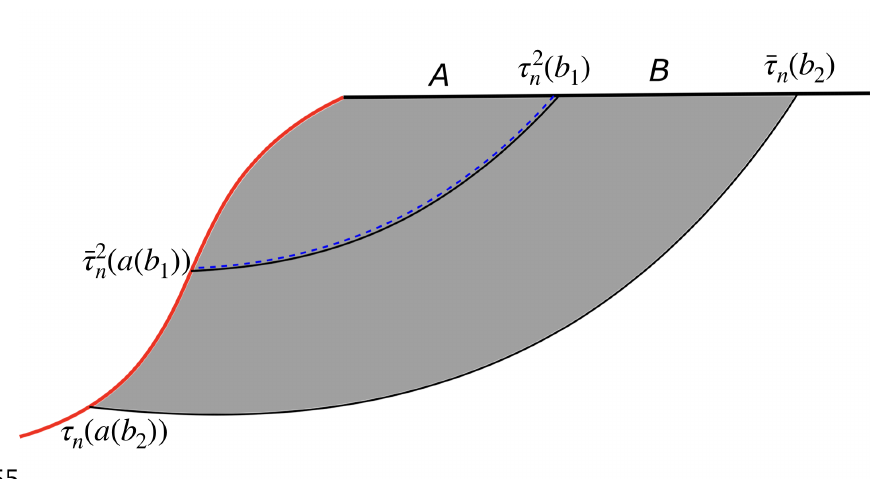
Figure 12: Schematic of the island proposal-II for the entanglement negativity of the mixed state of the adjacent intervals in phase-I. Figure modified from [ 68 ]